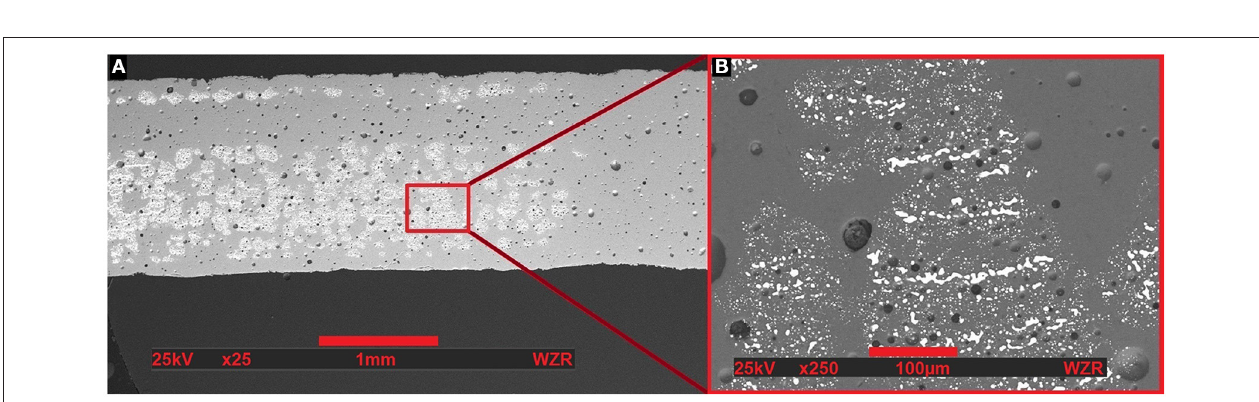
FIGURE 4 | Scanning Electron Microscopy of a cross-section of the first prototype with a magnification level of 25 (A) and 250 (B). The structure is upside-down. There are many pores in the glass-ceramic material (gray). However, the silver particles (white), and the glass-ceramic material formed a fully merged composite without pores at the interfaces. Many regions within one layer remained without silver, assumingly because the printed silver binder was not spread out homogenously. Furthermore the concentration of silver in the binder was not sufficient to build up a closed